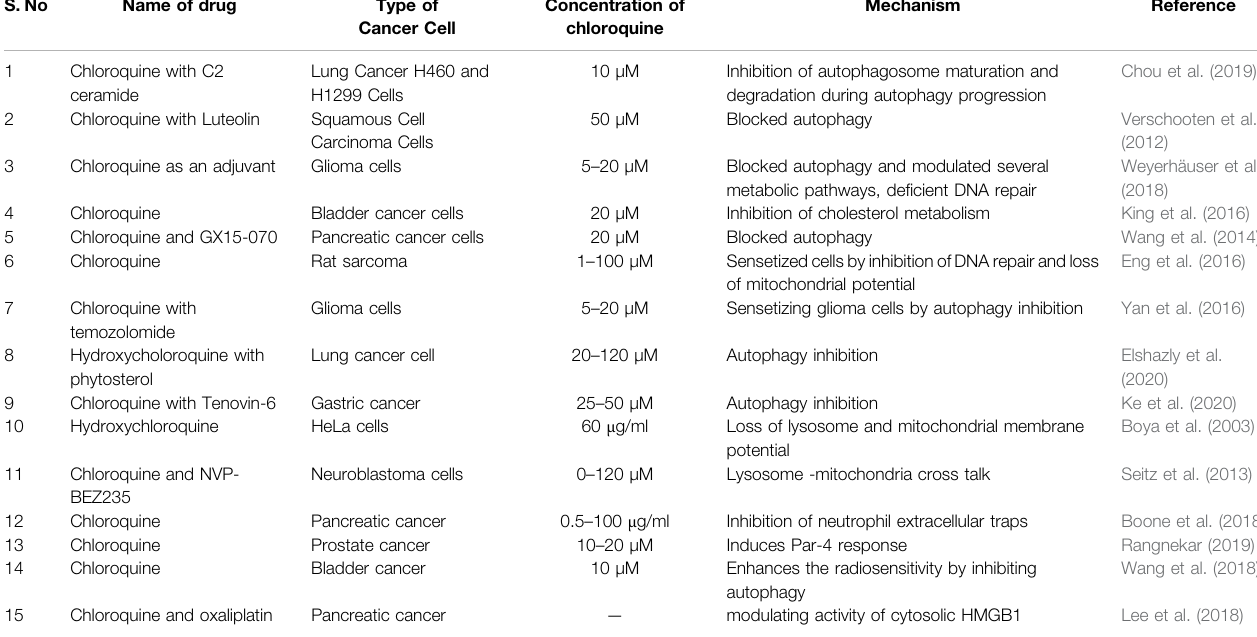
TABLE 1 | Examples of chloroquine used in treatment of